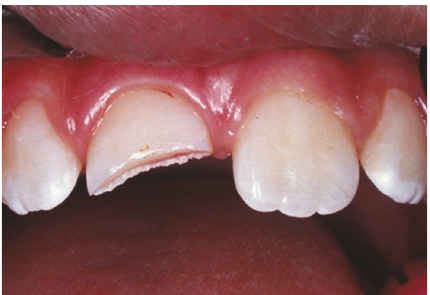
Figure1:Clinicalaspectsofthecrownfractureofthemaxillaryright central